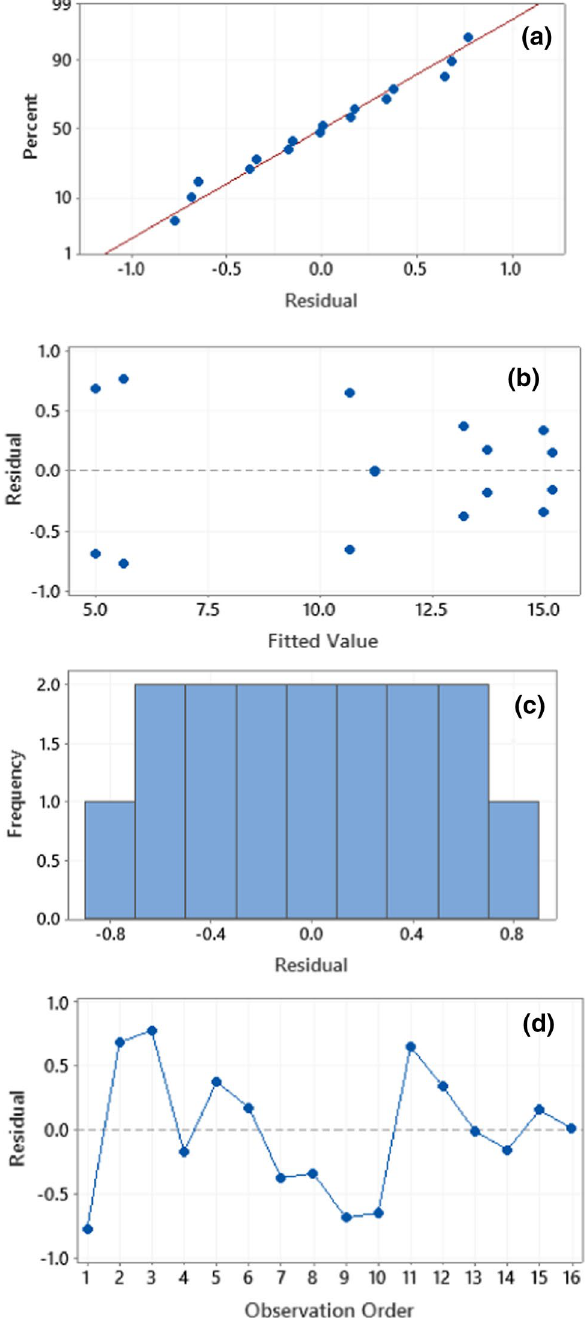
Fig. 4 Residual plots for water flux (L/m 2 ·h) using NaCl DS showing a normal probability plot, b residual versus fitted flux value, c fre- quency versus residual, and d residual versus observation